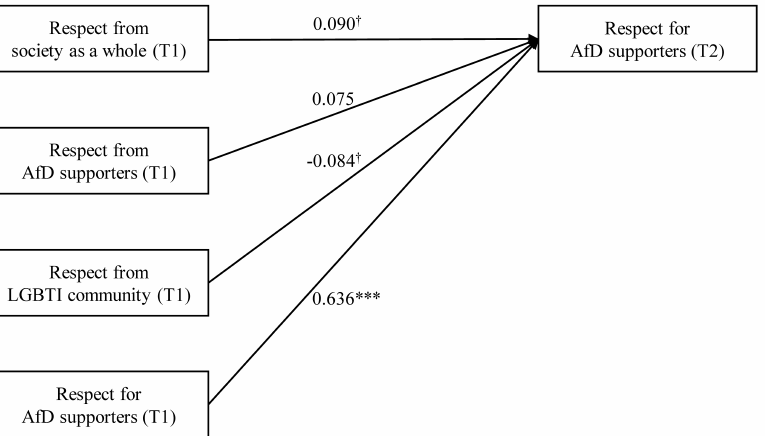
Figure 2. Antecedents of respect for supporters of the German populist right-wing political party “Alternative für Deutschland” (AfD) in a sample of German LGBTI community members ( N =